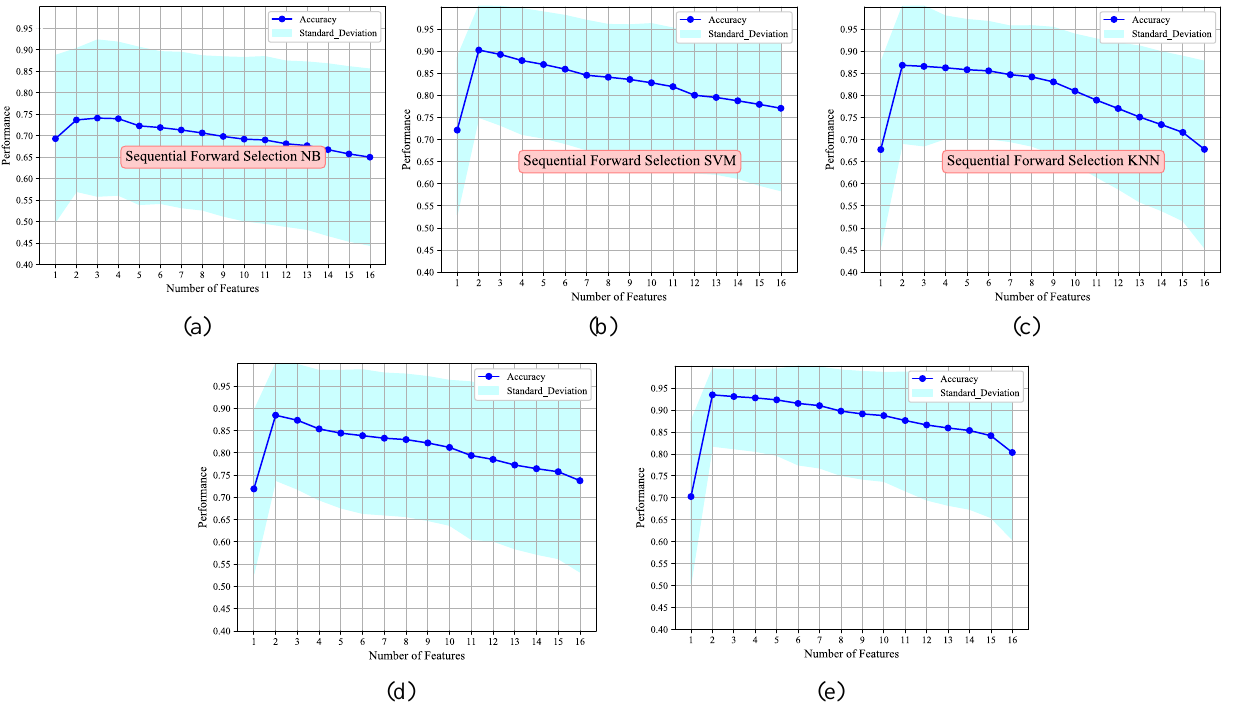
Figure 17. The performance of learning algorithms during the feature selection process in FC layer, ( a ) NB classifier, ( b ) SVM classifier, ( c ) KNN classifier, ( d ) EN classifier with majority vote, and ( e ) the proposed method. Table 9. Validation results of the FC